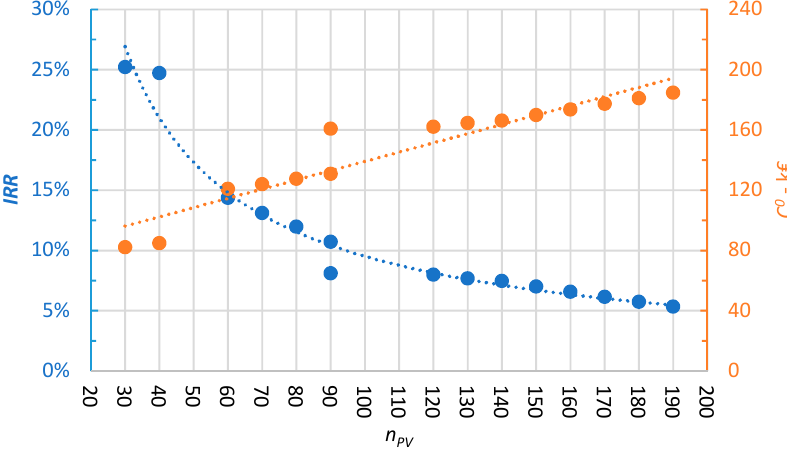
Figure 8. Internal rate of return ( IRR ) and initial cost as a function of the number of PV modules number.